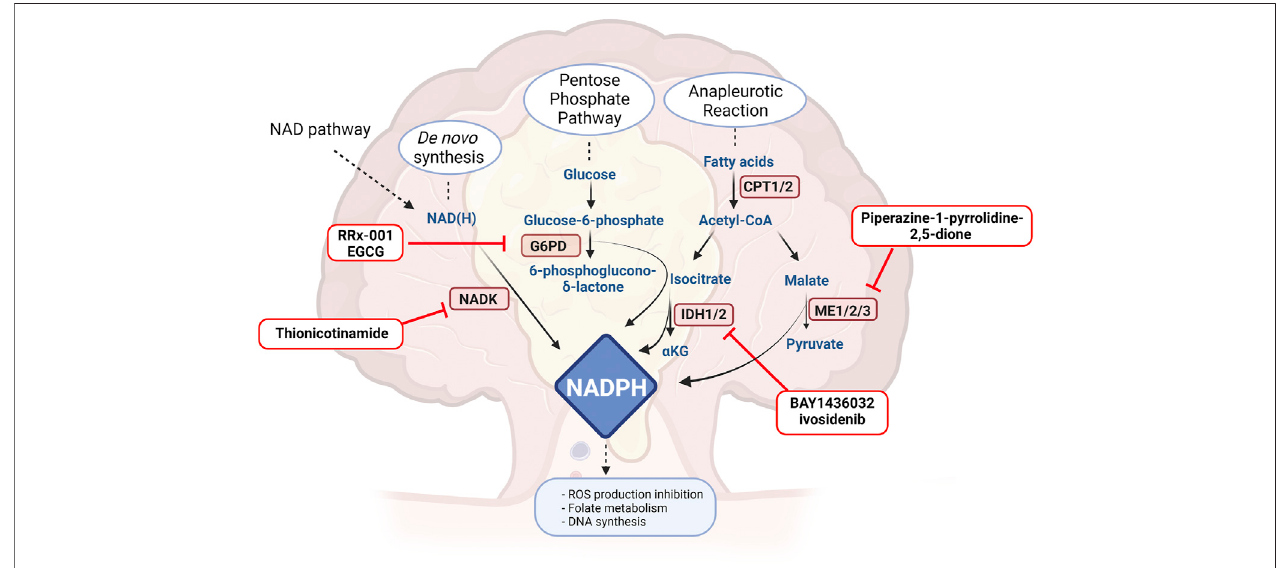
FIGURE 1 | Drugs or molecules that have been postulated as effective in CRC and that target NAD routes. NAMPT: nicotinamide phosphoribosyltransferase, NAPRT: nicotinic acid phosphoribosyltransferase, NMNAT: nicotinamide mononucleotide adenylyltrasnferase, NADSYN: NAD synthetase, PARP: Poly-ADP ribose polymerase, ALDHs: aldehyde dehydrogenase. Created with